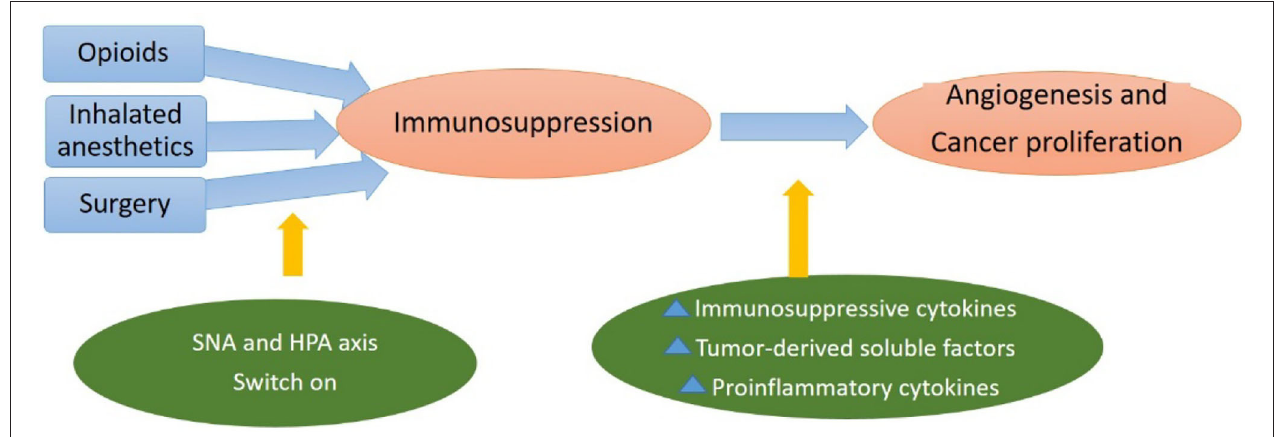
FIGURE 2 | Hypothalamic–pituitary–adrenal (HPA)-axis and sympathetic nervous system (SNS) activation by anesthetic agents suppress cell-mediated immunity and release factors increasing immunosuppressive cytokines, soluble factors, and proinflammatory cytokines, which promote tumor angiogenesis and metastasis.